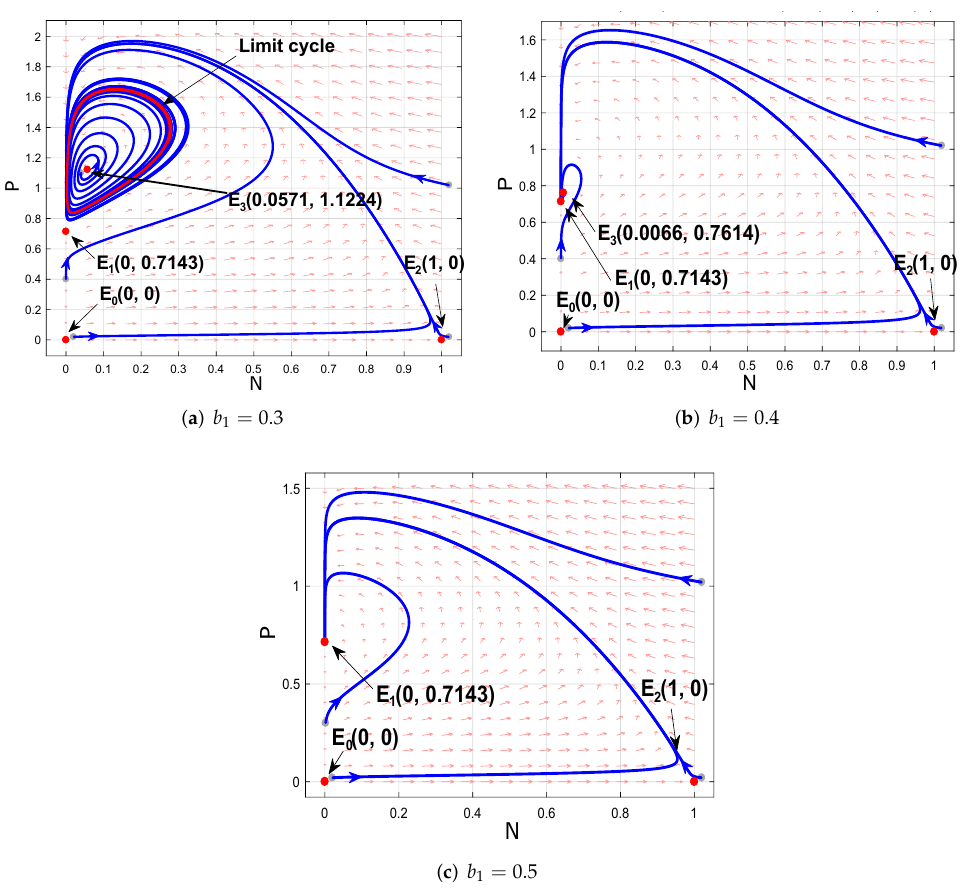
Figure 2. Phase Portraits of the system (3) with parameter values as in Table 1 and ( a ) b 1 = 0.3, ( b ) b 1 = 0.4, and ( c ) b 1 = 0.5.